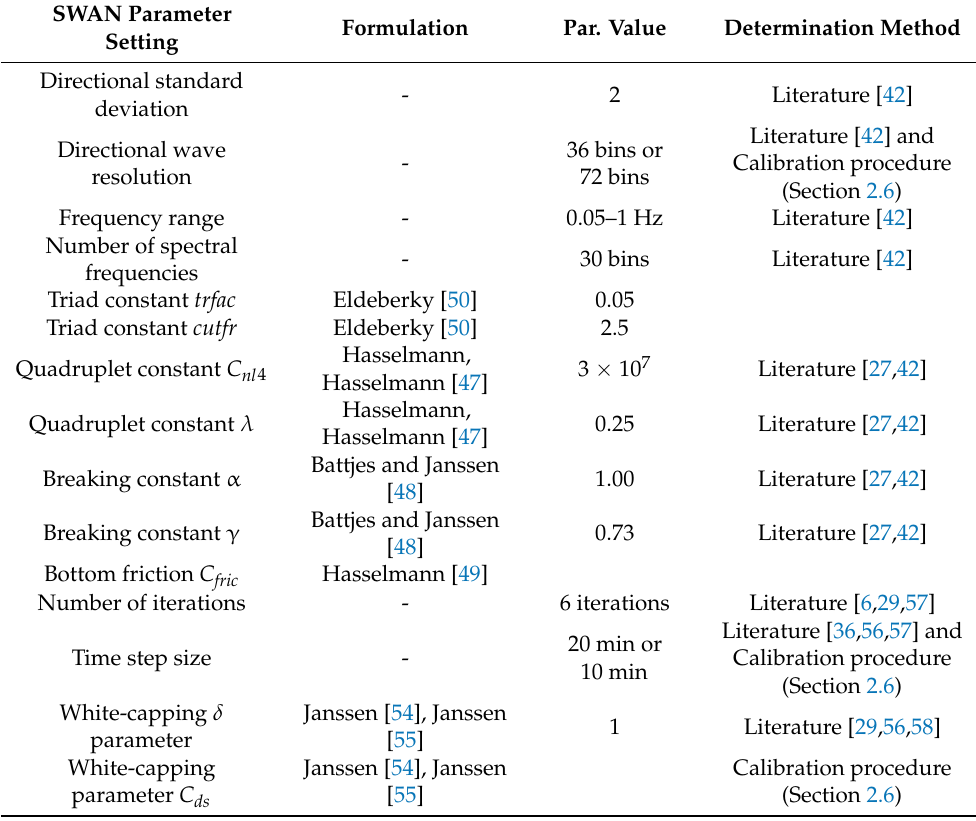
Table 1. Summary of used empirical formulations and parameter